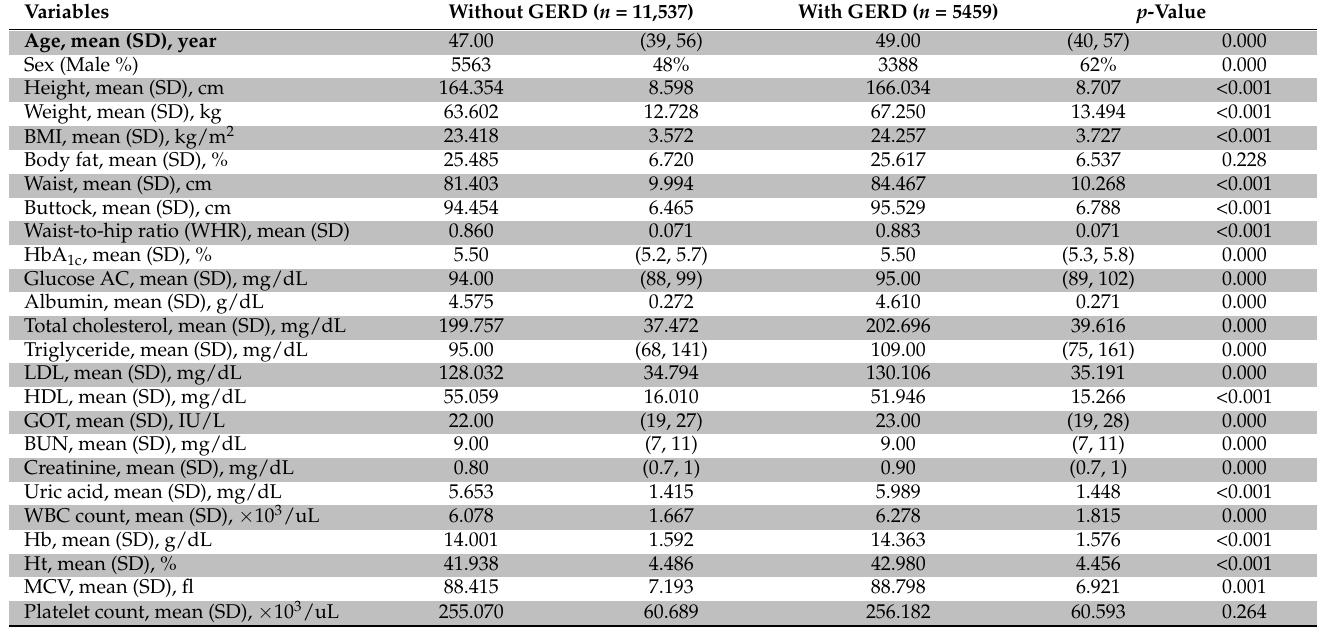
Table 1. Baseline characteristics (presented with mean and SD, median and IQR, or n and %). Variables Without GERD ( n = 11,537) With GERD ( n = 5459) p -Value Age, mean (SD), year